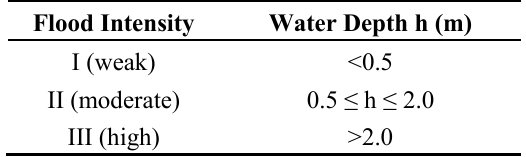
Table 4. Risk Estimation: Used flood intensity classes according to